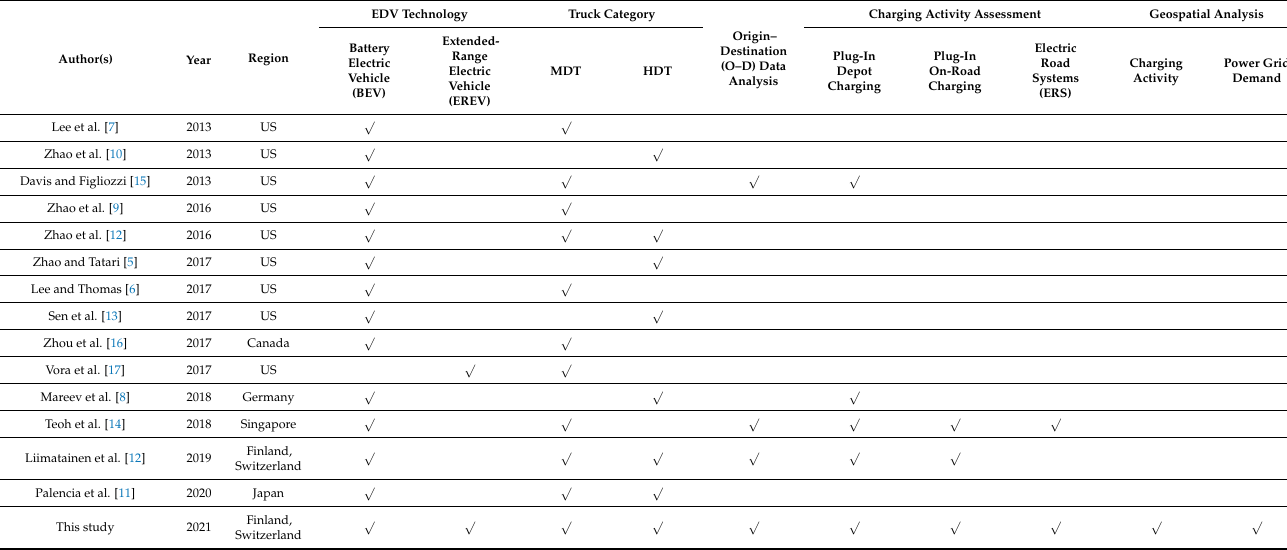
Table 1. Summary of global research on electric-drive vehicle (EDV) technology adoption for medium-duty trucks (MDTs) and heavy-duty trucks